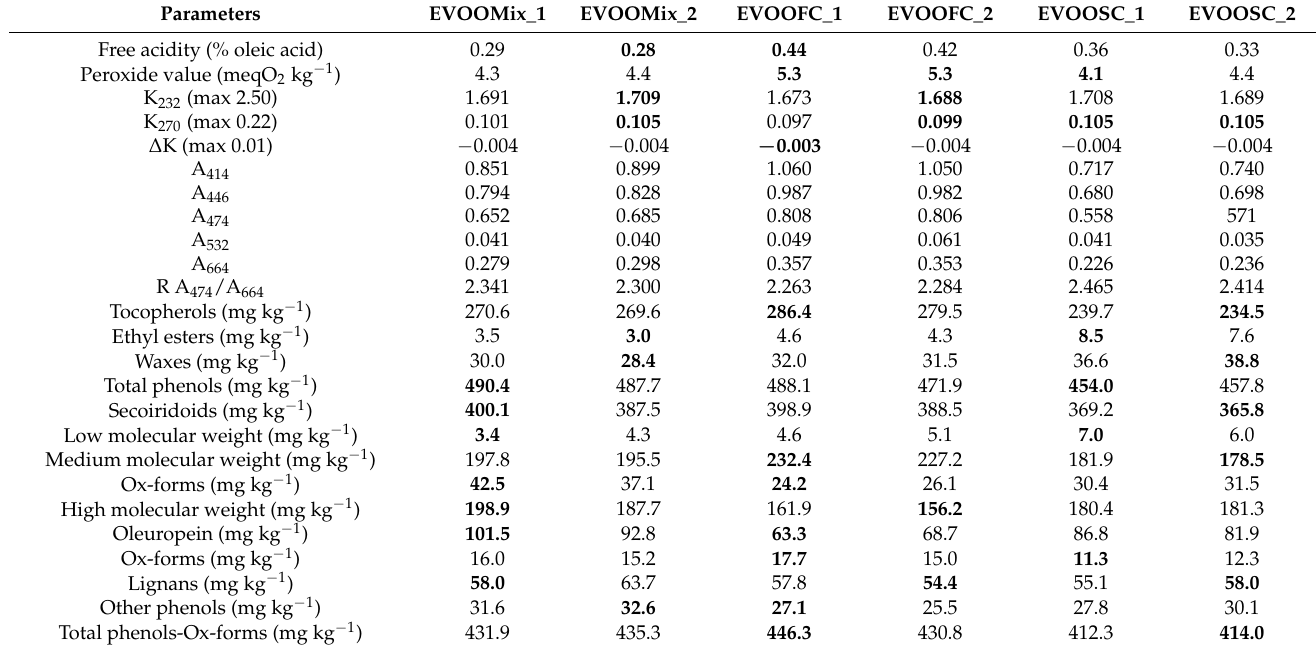
Table 4. Chemical-physical and chemical results of the analysed EVOOs.